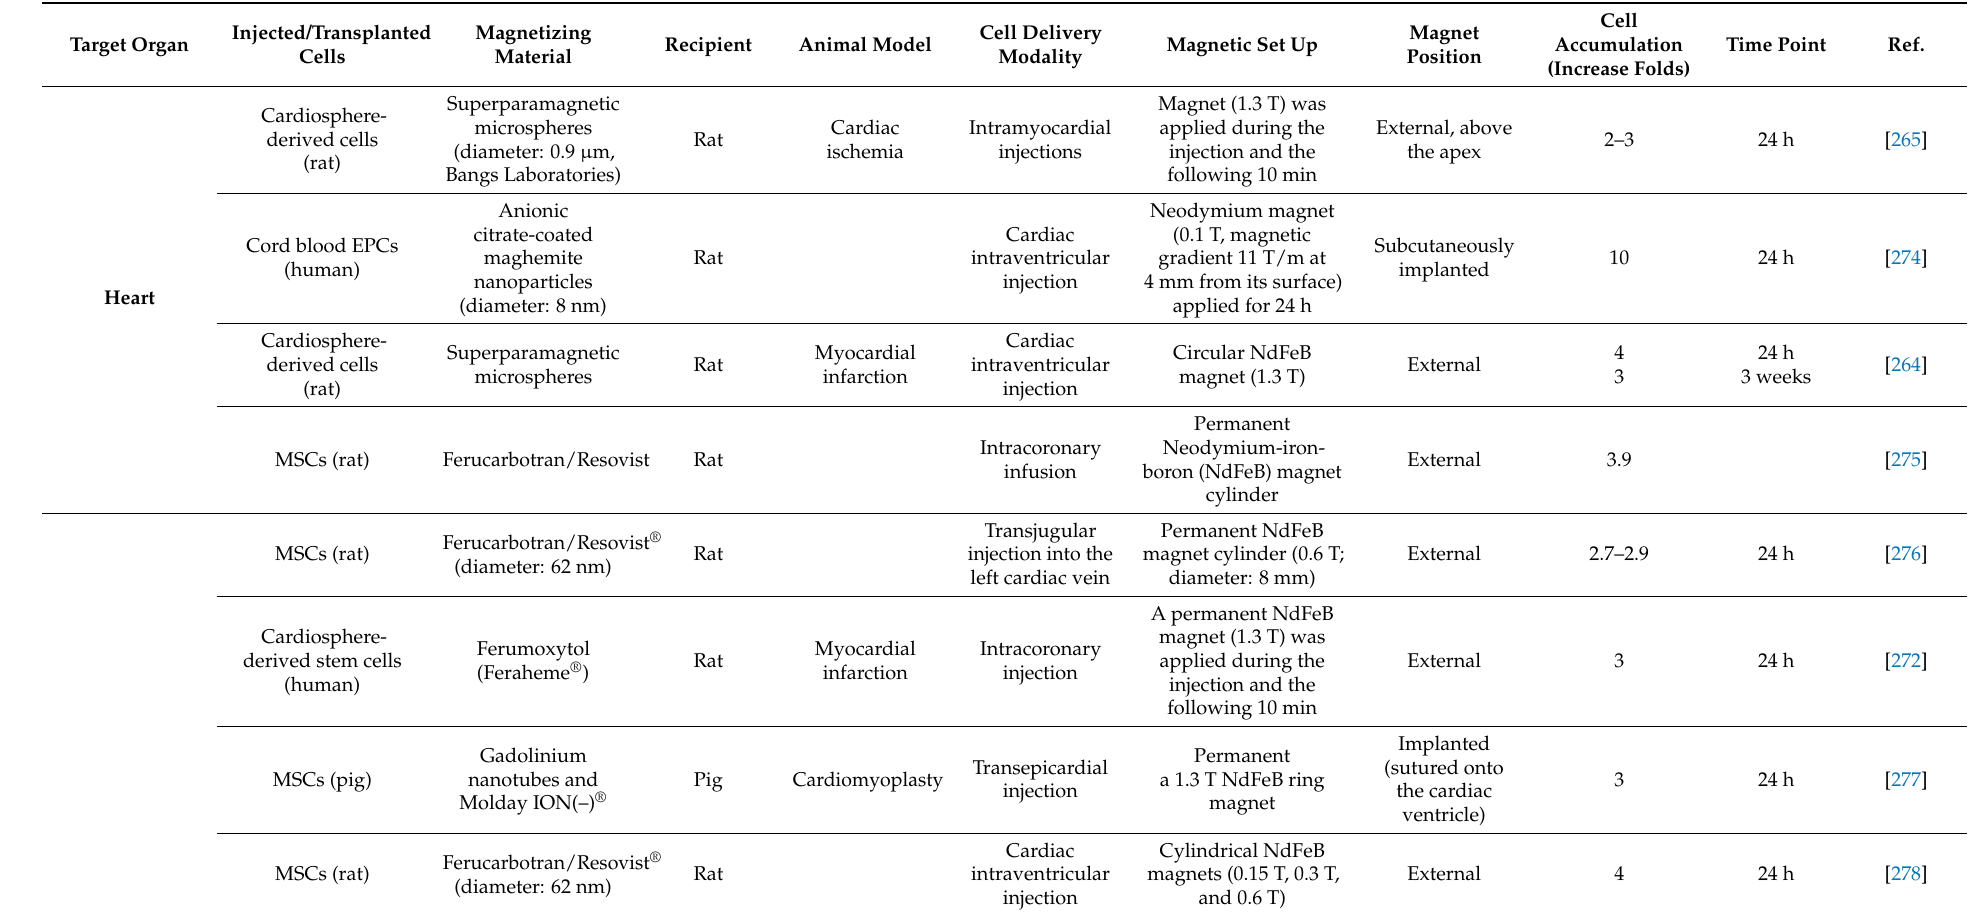
Table 1. In vivo studies of magnetic cell targeting categorized in relation to the target